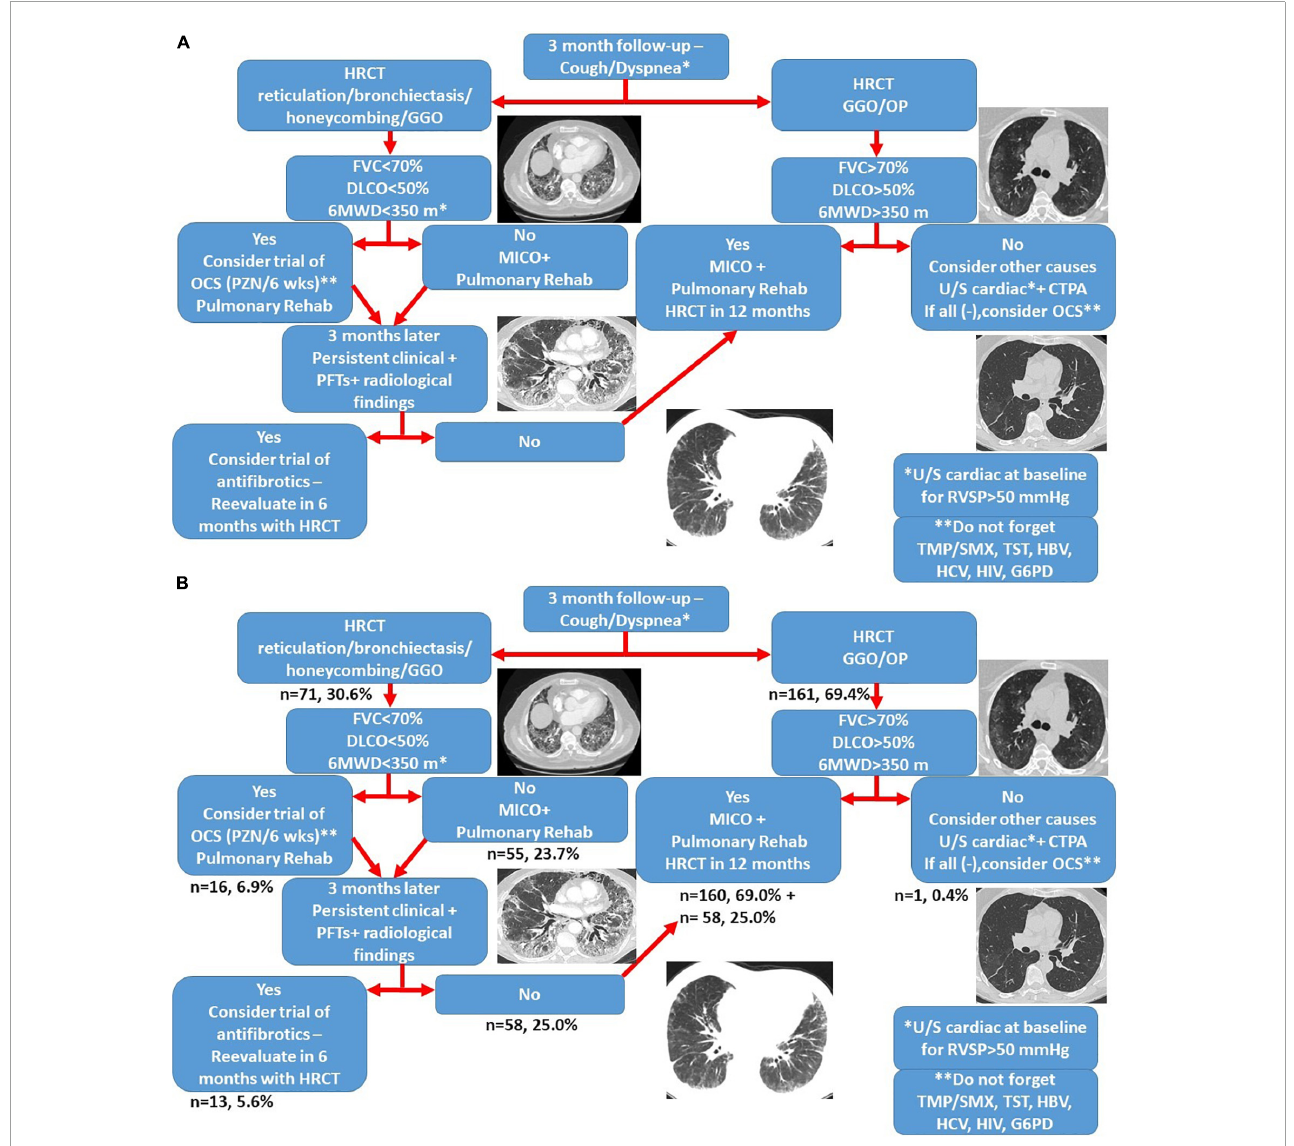
FIGURE4 Treatment algorithm for patients with post-COVID-19 interstitial lung disease (A) . The proportion of patients that belongs to each group is shown in panel (B) . CTPA, computed tomography pulmonary angiogram; GGO, ground glass opacities; G6PD, glucose-6-phosphate dehydrogenase; HBV, hepatitis B virus; HCV, hepatitis C virus; HIV, human immunodeficiency virus; MICO, masterful inactivity with cat-like observation; OCS, oral corticosteroids; OP, organizing pneumonia; TMP/SMX, trimethoprim-sulfamethoxazole; TST, tuberculin skin test; 6MWD: 6 min walking